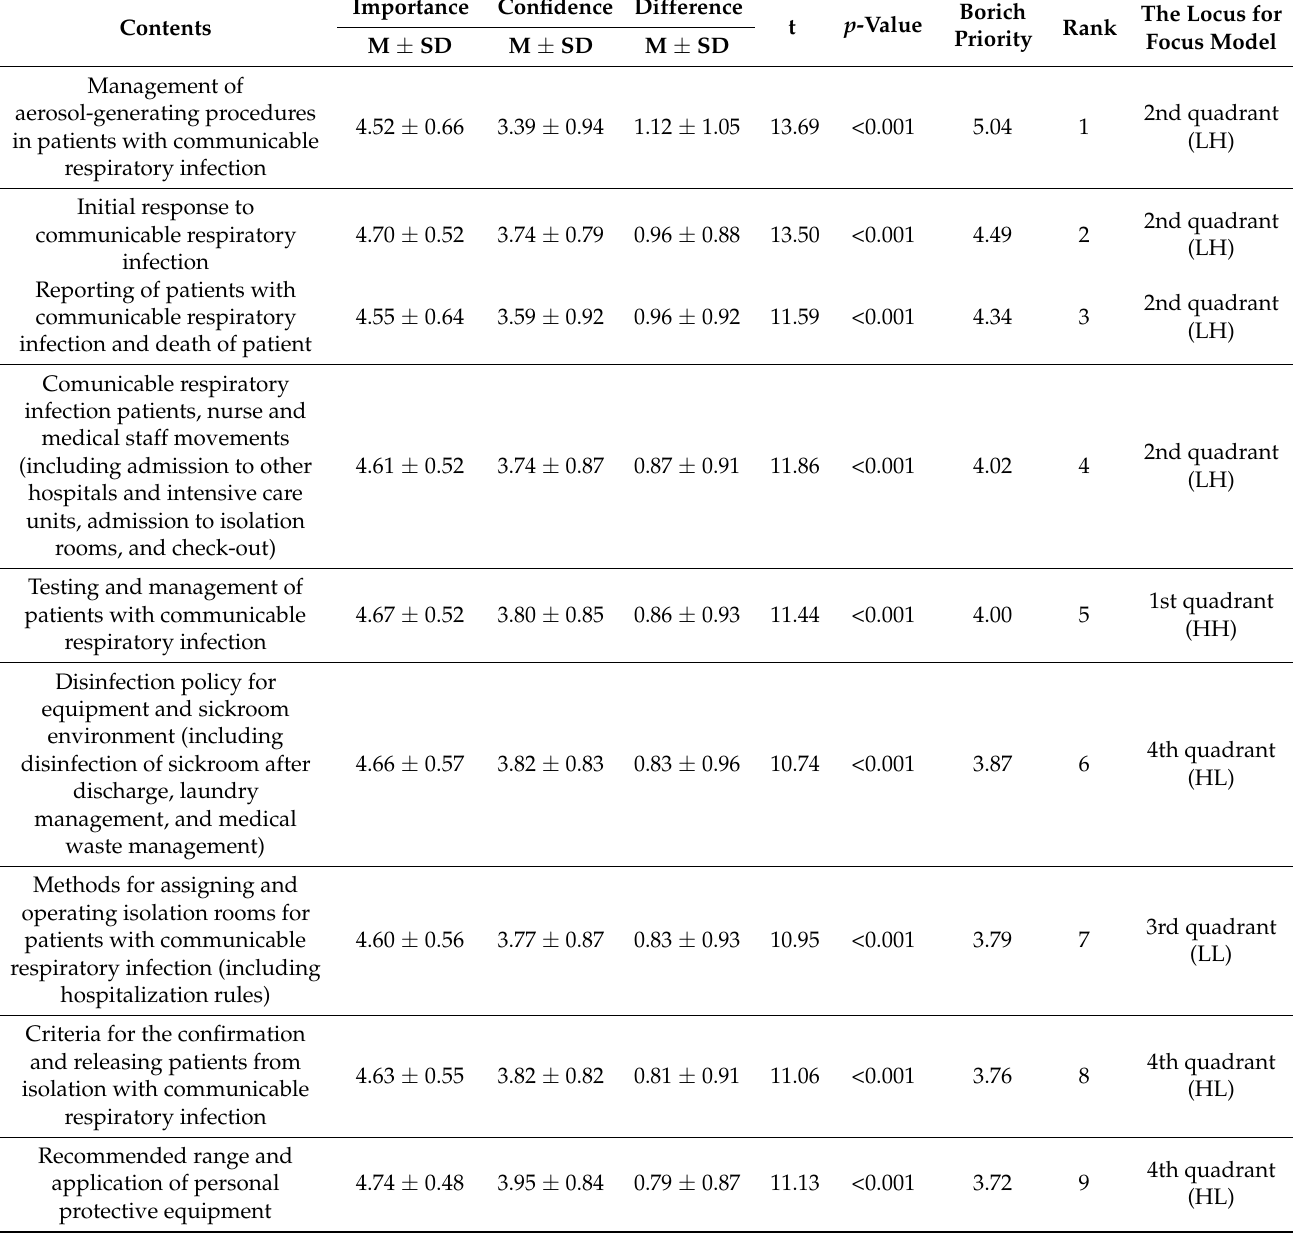
Table 3. Analysis of educational needs and priority of education among participants without prior experience in COVID-19 patient